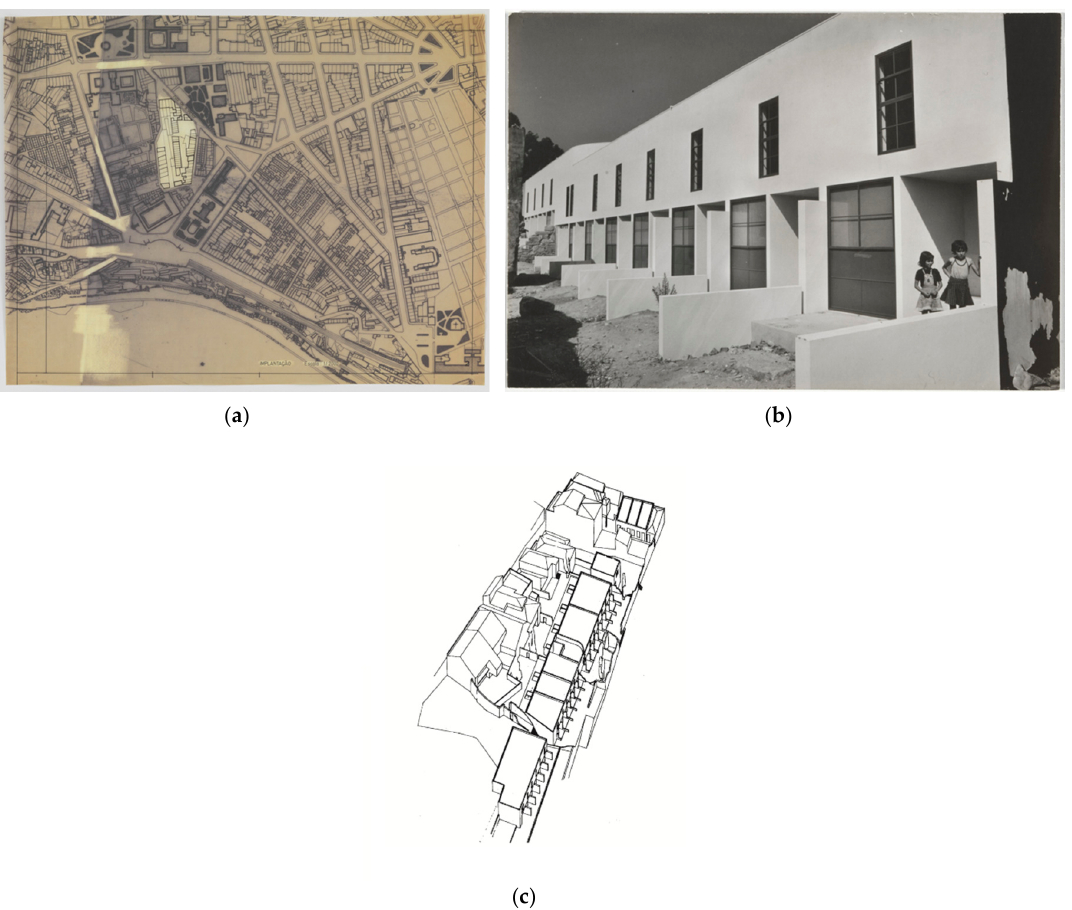
Figure 4. Serviço Ambulatório de Apoio Local (SAAL) Estate of Sao Victor, Porto, Portugal, by Architect Alvaro Siza 1974–77 ( a ) Site plan; ( b ) View of main façade, circa 1977 ( c ) Axonometric view.